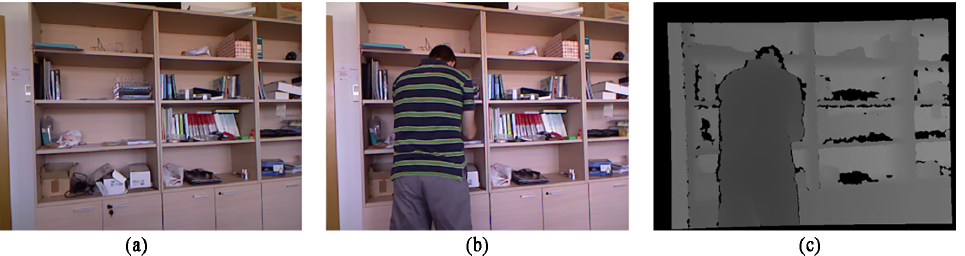
Figure 12. Sampling map of Experimental Scenario Three: ( a ) Background image; ( b ) Color image of the 390th frame; ( c ) Depth image of the 390th frame.